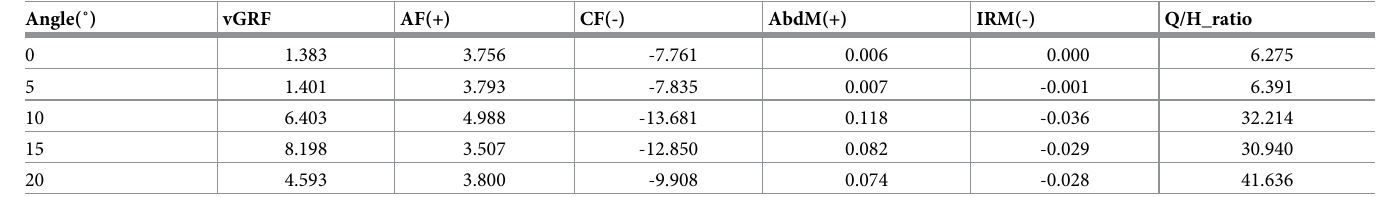
Table 6. Vertical GRF, knee JRF and JRM and Q/H force ratio at peak vGRF time instance for multiple lumbar extension angles.